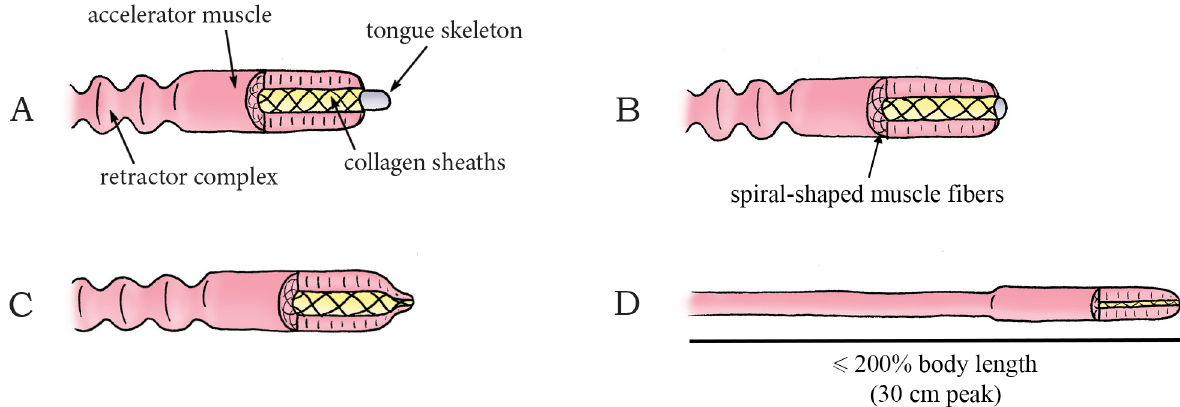
Fig 23. The muscle-powered squeeze catapult mechanism in the family Chameleonidae or chameleons (species Chameleo pardalis ). (A) The chameleon tongue consisting of the tongue skeleton (entoglossal process), accelerator and retractor muscles, and nested collagen sheaths. (B) Activation of spiral-shaped muscle fibers in the accelerator muscle leads to radial contraction and elongation of the muscle and stretches the helically wound collagen fibers in the sheaths. (C – D) The accelerator muscle and sheaths slide off the tip of the bone, releasing the stored elastic energy, and forcing the tongue forward. Drawings based on schematic drawings in [30]. Scale bar indicates a length of up to 200% body length (peak distance of 30 cm in Chameleo calyptratus [30]).